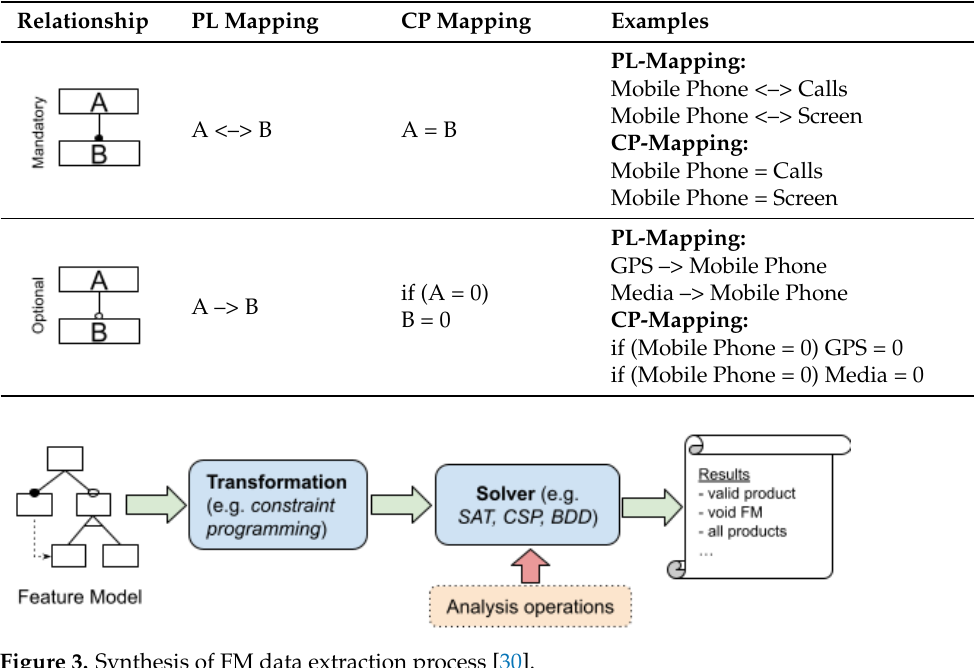
Figure 3. Synthesis of FM data extraction process